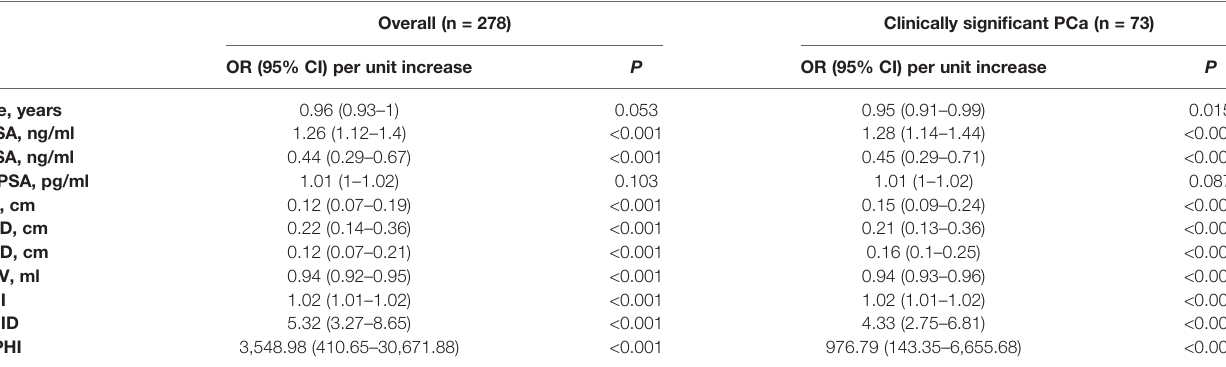
TABLE 2 | Univariable logistic regression models for the PSA gray zone clinically signi fi cant PCa prediction. Overall (n = 278) Clinically signi fi cant PCa (n = 73) OR (95% CI) per unit